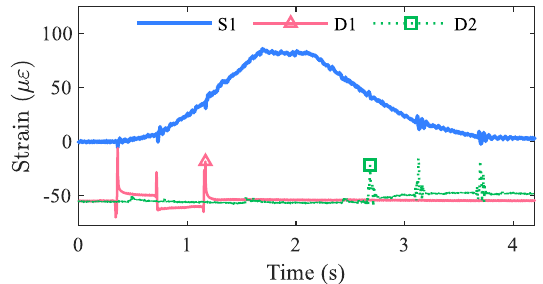
Figure 15. Typical measured strains ( v =2.02 m/s).